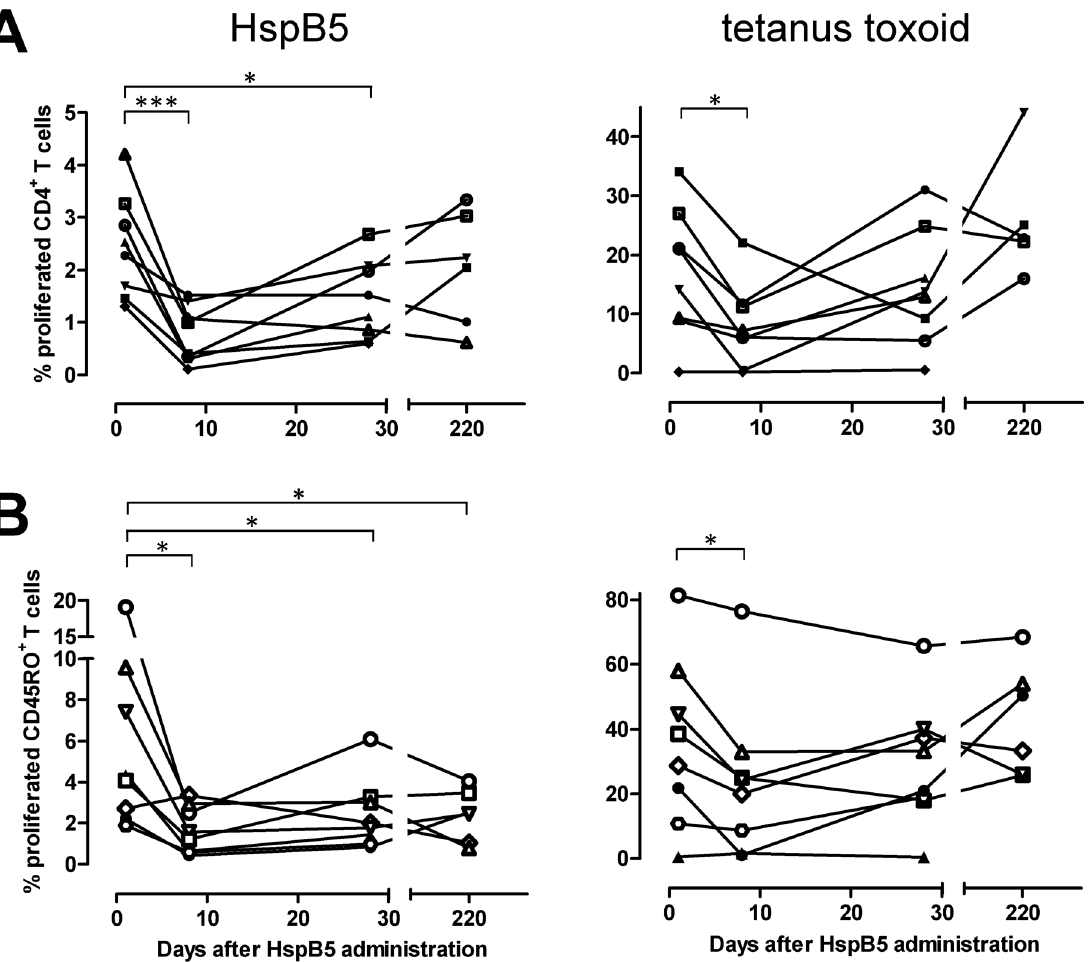
Fig 3. Effects of intravenous HspB5 on peripheral T-cell reactivity to HspB5 itself, and tetanus toxoid. Fig 3 illustrates the proliferative response in vitro of CD4 + (A) as well as CD45RO + memory T-cells (B) to either 50 μ g/mL HspB5 or 0.2 μ g/mL tetanus toxoid as a control antigen, at various time points after a single intravenous dose of 12.5 mg HspB5 in 8 healthy subjects, as evaluated using a CFSE assay during Phase I. Percentages of proliferated CFSE dim cells are expressed relative to all other lymphocytes detected by flowcytometry in the sample after 9 days in culture, including CD4/CD45RO- negative cells. The results not only confirm that following an intravenous dose of 12.5 mg HspB5, its levels remain at sub-immunogenic levels, but even illustrate significant suppressive effect on in vitro T-cell reactivity that is markedly more lasting for HspB5-reactive T cells than for tetanus toxoid-reactive T cells. Background proliferation found in cultures without any antigen was well below 1% in all cases. * : p < 0.05; *** : p < 0.005.